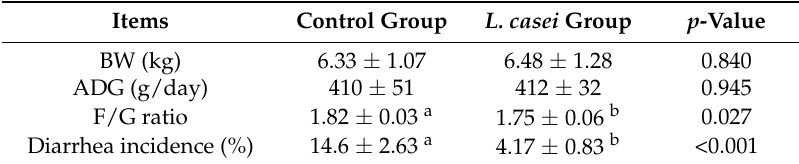
Table 1. Effect of dietary supplementation with L. casei on the growth performance of piglets during Days 1–30 of the